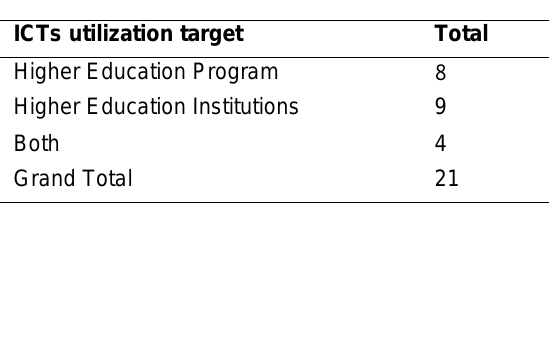
Table 4. Frequency of Studies on tool development and practical experiment design (RQ3)